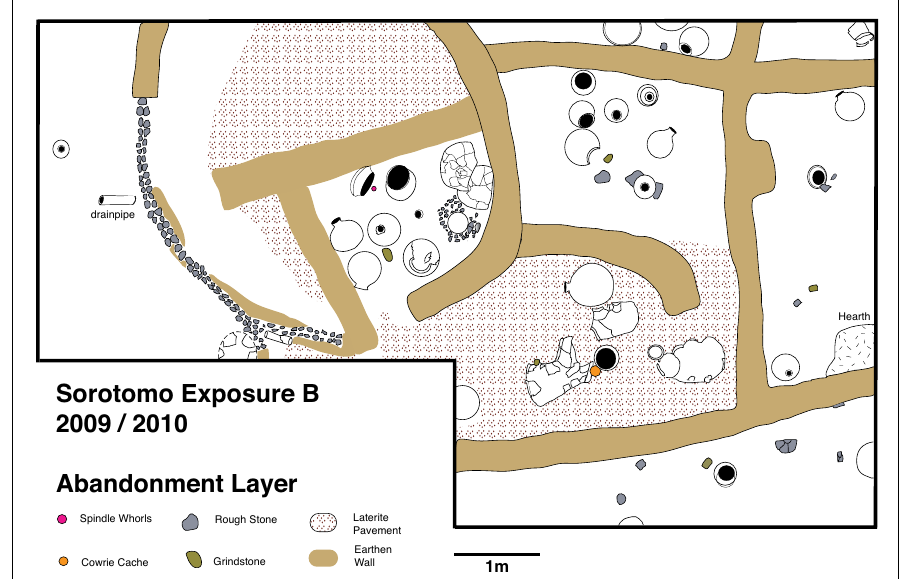
Fig. 5: Plan of Unit B abandonment